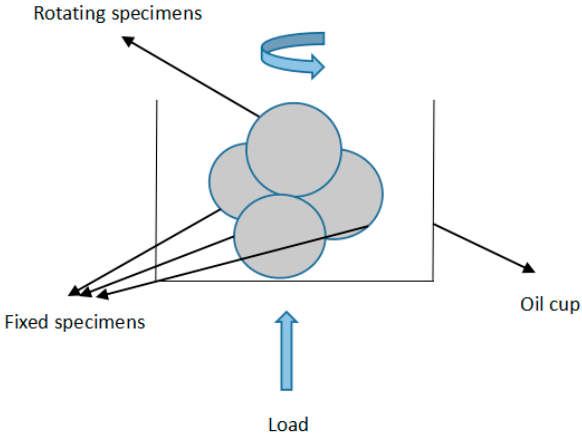
at different temperatures and for different loads and reciprocating speeds under different lubrication conditions [13].